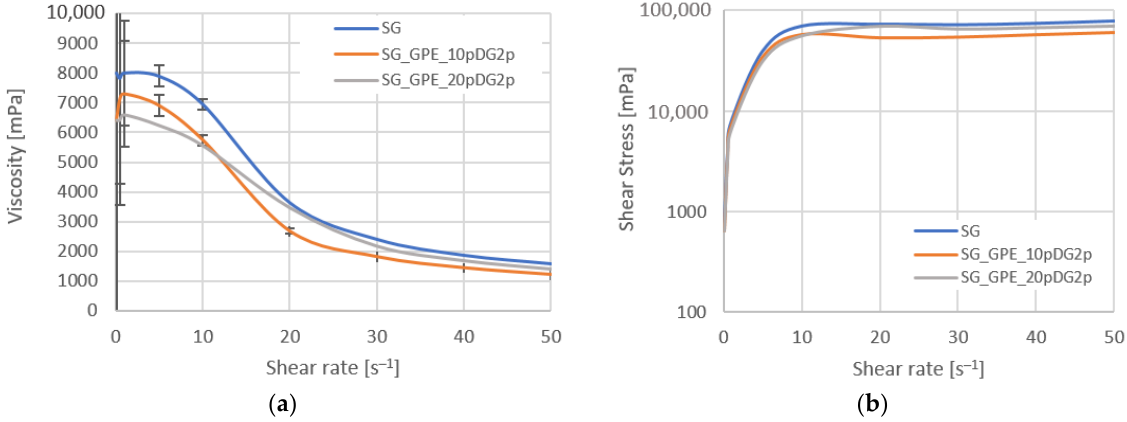
Figure 8. Rheogram of detergents; ( a ) Viscosity vs. shear rate; ( b ) Shear stress vs. shear